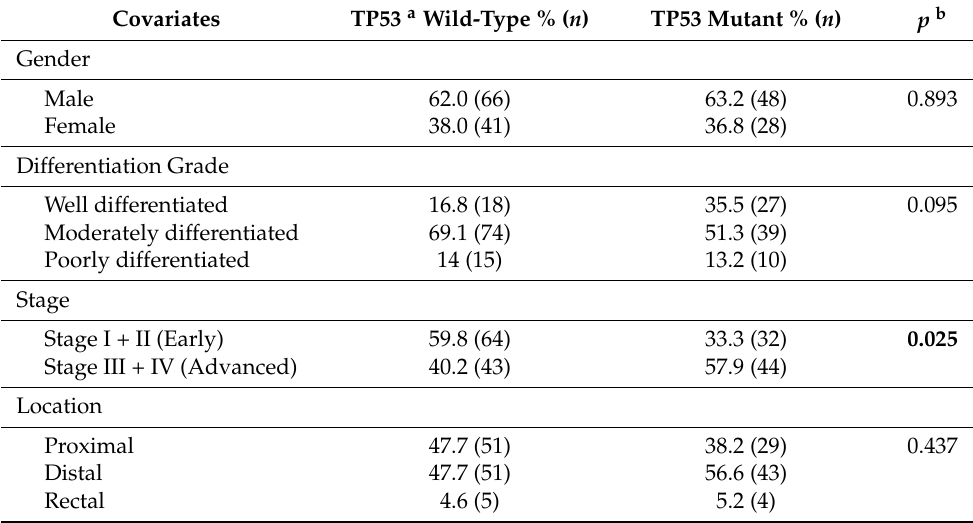
Table 1. Prognostic covariates.